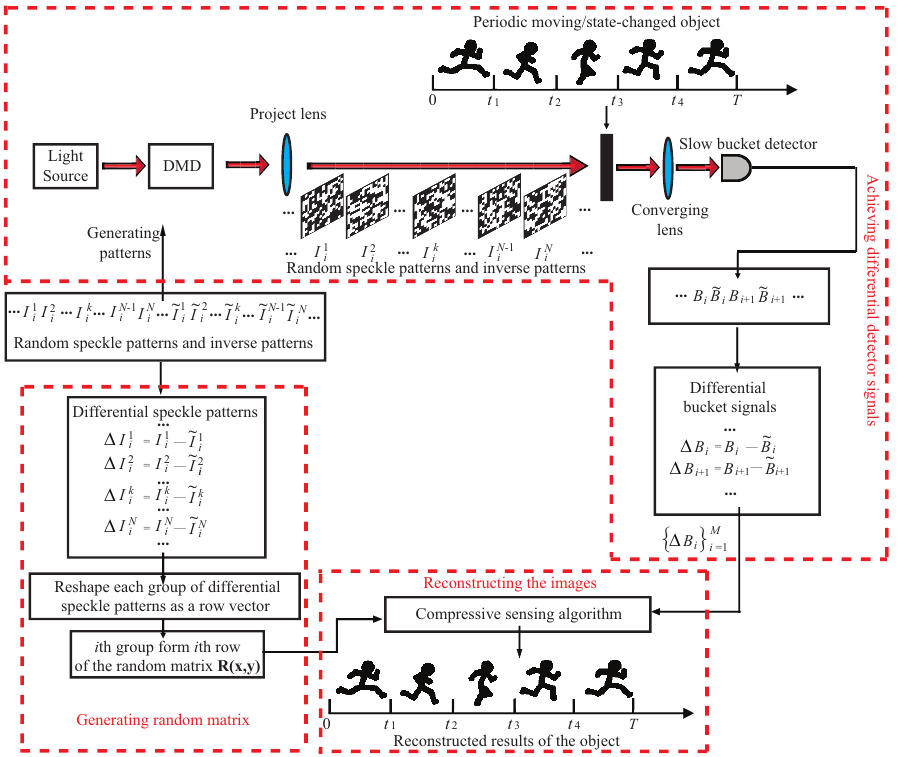
Figure 1. A schematic diagram of the